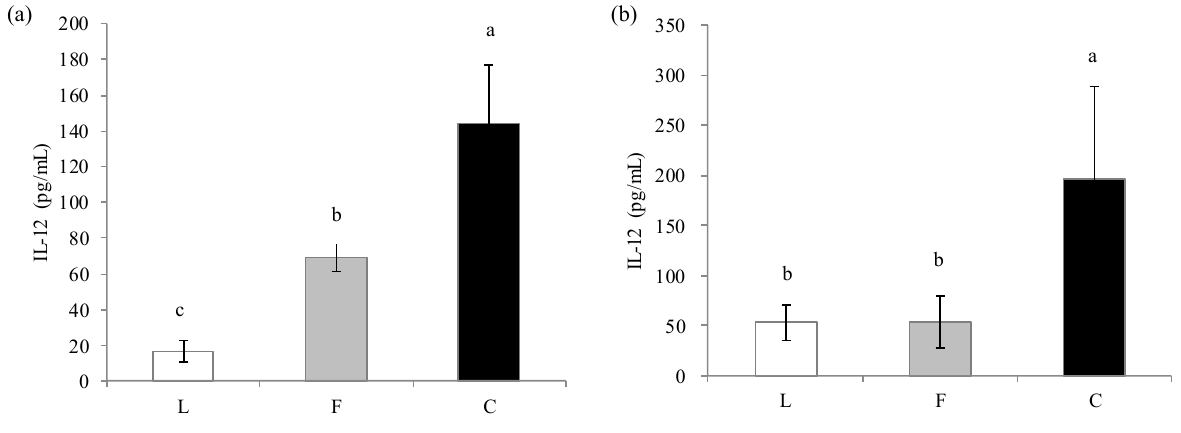
Figure 3: Production of the cytokine IL-12 in the spleen cells and Peyer’s patch (PP) cells in mice fed experimental diets after 6 weeks; (a) spleen cells. (b) PP cells. L: lard diet; F: fish oil diet; C: coconut oil diet. Values represent the mean ± SD (n=5). Within each panel, values not sharing a common superscript letter are significantly different at p